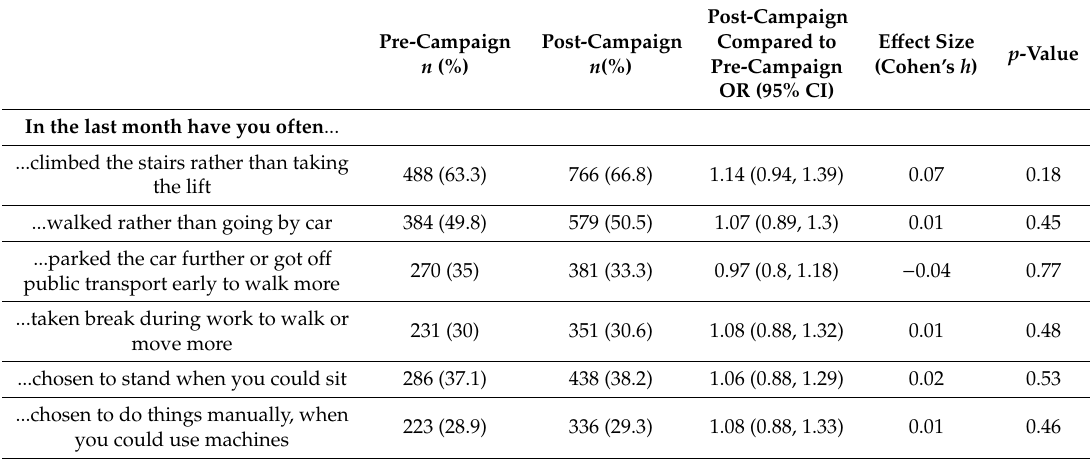
Table 5. Adjusted odds of lifestyle physical activity behaviours post-campaign compared to pre-campaign.